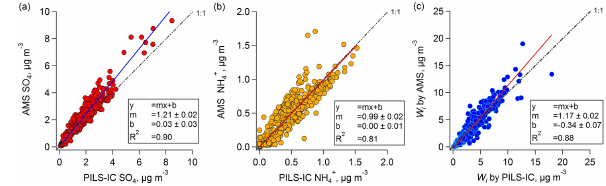
Figure 2. Comparisons of PM 1 AMS sulfate, ammonium to PM 1 and PM 2 . 5 PILS-IC (i.e., complete SOAS study) and predicted W i . Orthogonal distance regression (ODR) fits were